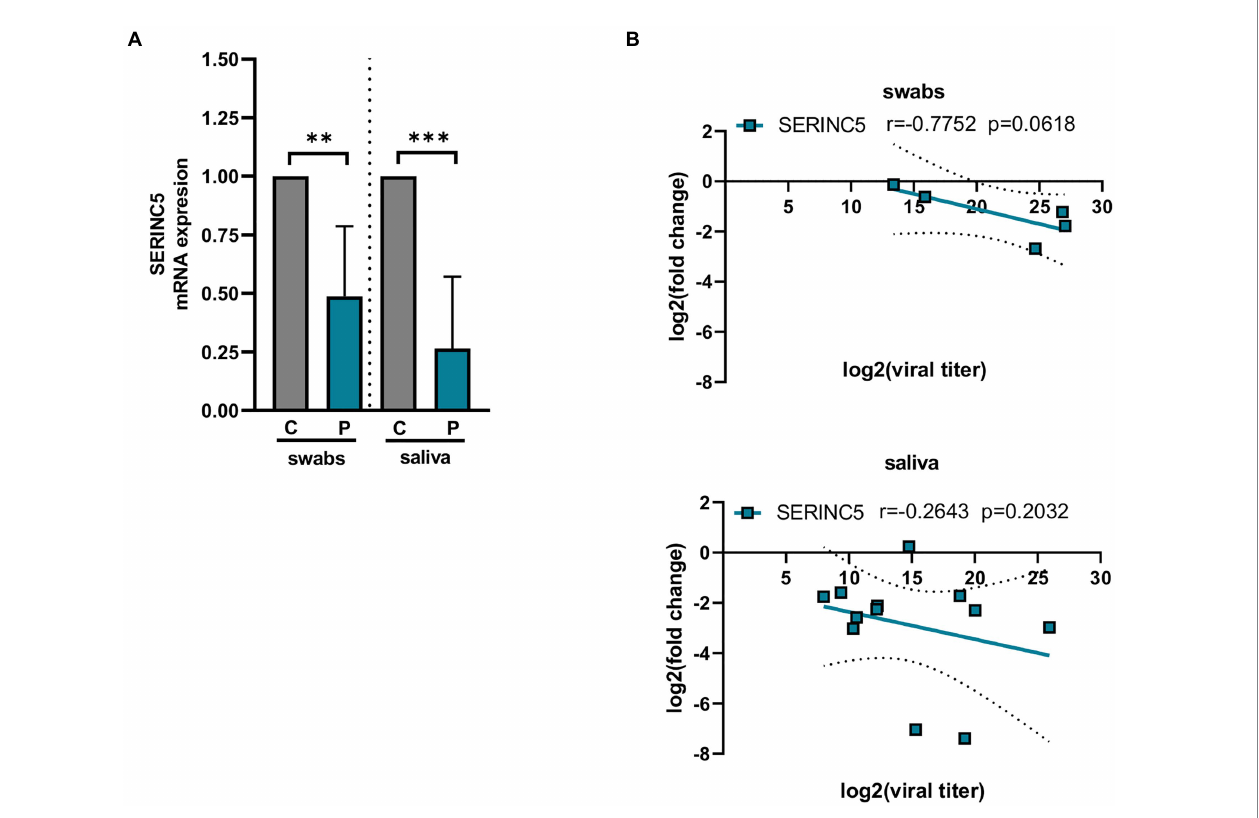
FIGURE 1 Analysis of the levels of SERINC5 mRNA in nasopharyngeal and saliva samples of COVID-19 patients. (A) RT-qPCR analysis of the expression of SERINC5 mRNA in nasopharyngeal (swabs) and saliva samples from COVID-19 patients (P) with respect to healthy patients (C). The control value represents the mean of all control samples. The ΔΔ Ct method was used for relative quantification using RPP30 mRNA as an endogenous control. Data are represented as log2 fold change with respect to control samples. (B) Correlation analysis between log2 fold changes obtained for SERINC5 mRNA and log2 viral titers in swabs (top) and saliva (bottom) samples. Viral titer was expressed as E mRNA copies/mL sample. Differences from control values were found to be statistically significant at * p < 0.05, ** p < 0.01, and *** p <